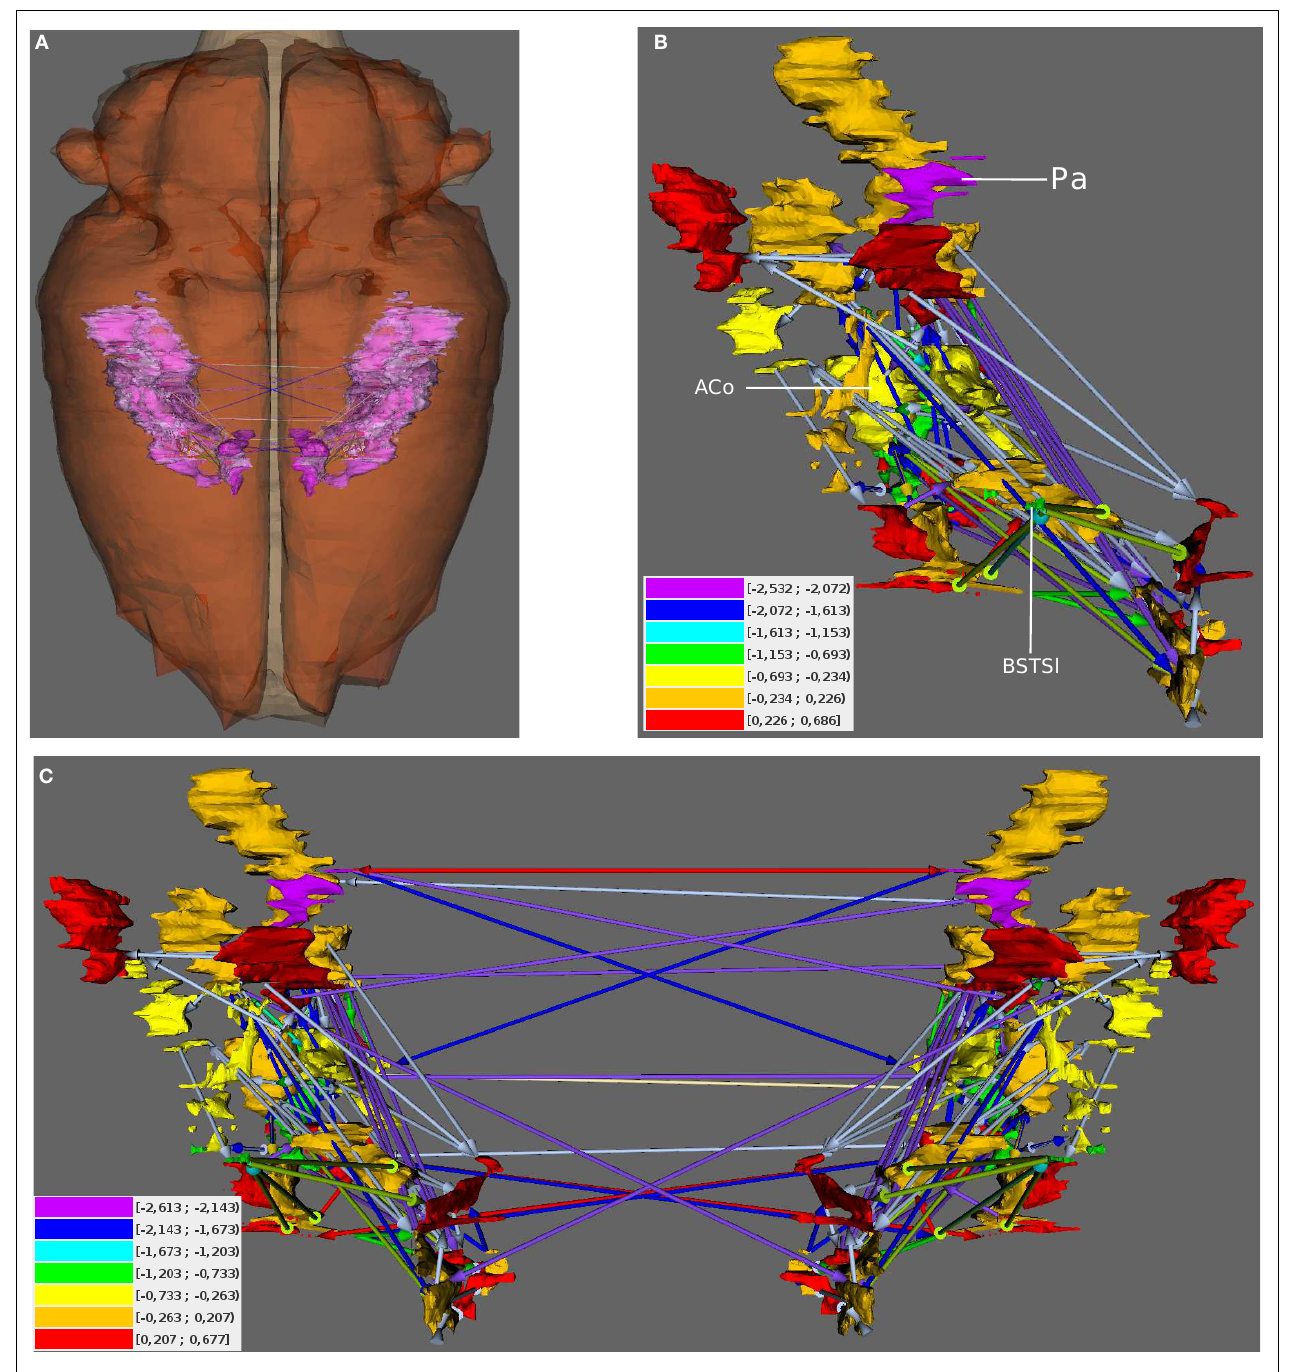
the lowest Shapley rates (see text) and color-coded weights of connections (color-codes of connections are the same as in Figure 5 ). Color-coded Shapley rates are assigned to regions. (C) Bilateral amygdala with ipsilateral and contralateral connections.